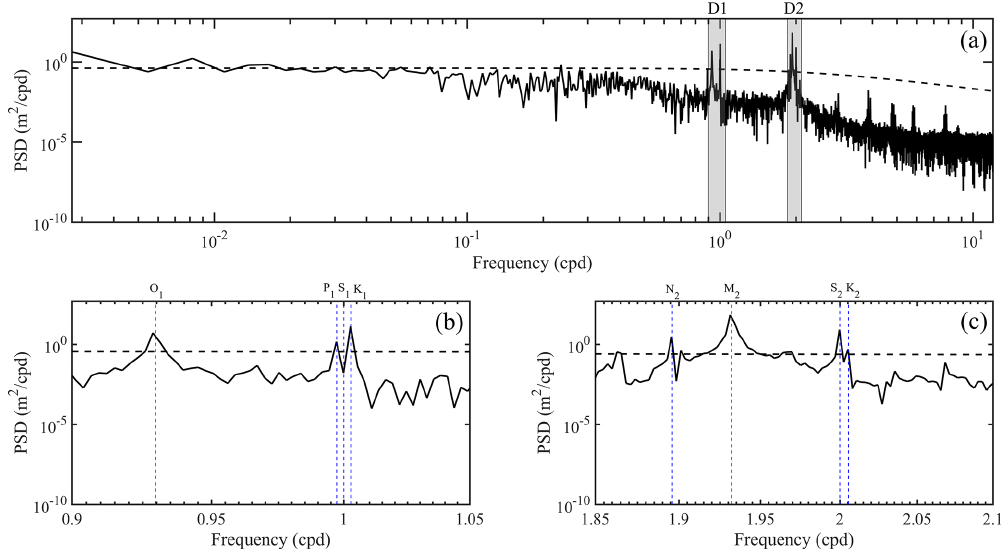
Figure 3. Power spectral densities of the observed sea level at E2 (black line) in (a) all frequency bands, (b) the diurnal frequency band, and (c) the semi-diurnal frequency band. In all panels, black dashed lines denote the corresponding 5% significance level against red noise.